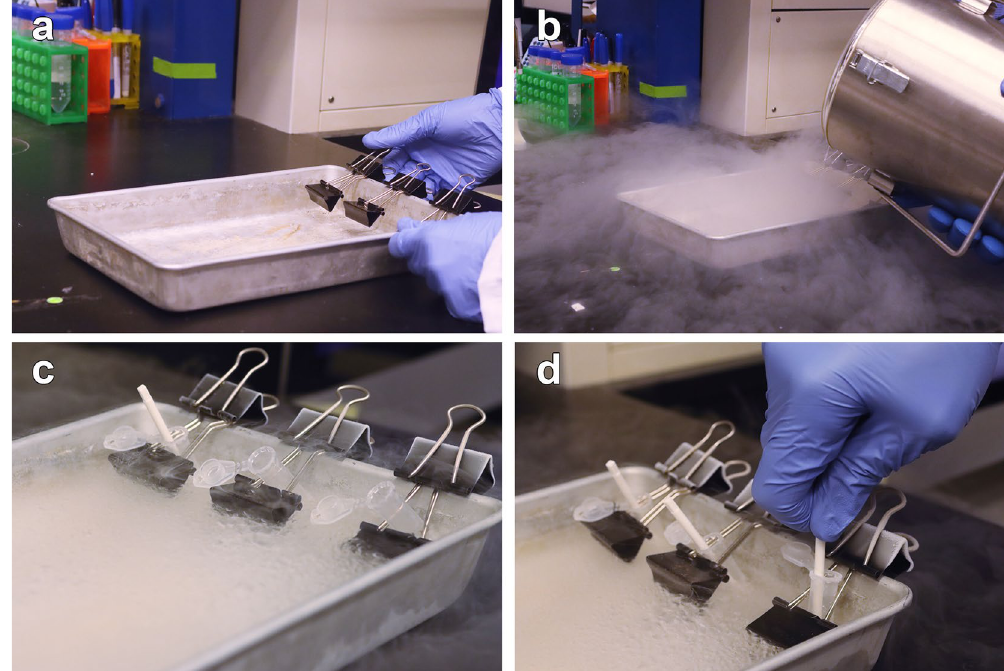
Figure 4. Setup of the apparatus that facilitated cryogenic disruption in RNase-free tubes as an alternative to tissue grinding via mortar and pestle. ( a ) Medium binder clips were attached to the lip of a surgical tray. Both metal wire arms of a complementary binder clip were wedged securely between the gripped section and the interior lip. ( b ) Liquid nitrogen (approx. 1 L) was poured directly into the tray. ( c ) BioMasherIII tubes containing the muscle fibers were stabilized by the looped arms of the attached clip. Once snap-frozen, tissues were crushed using disposable pestles. ( d ) Tissue grinding in liquid nitrogen ensued until fibers were finely broken